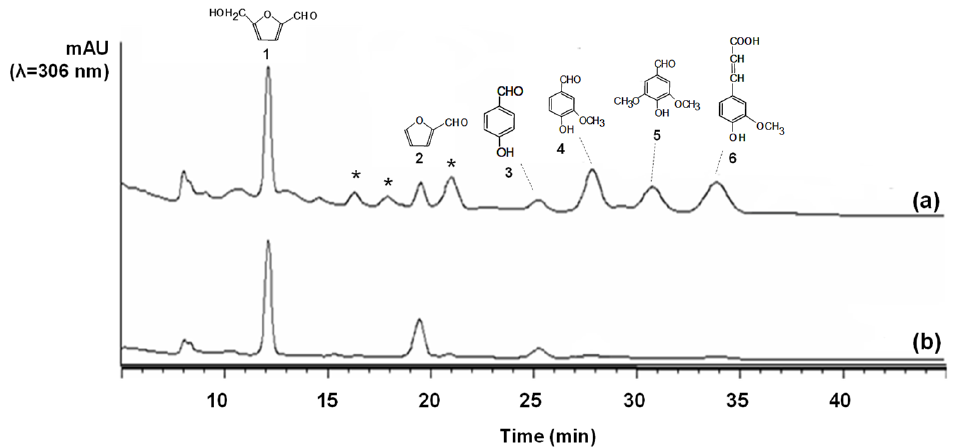
Figure 1. Comparison of high-performance liquid chromatography profiles of inhibitory com- pounds of liquid fraction enzymatic hydrolysates ( a, control; b , laccase). Identified peaks: 1, 5-HMF; 2, Furfural; 3, 4-hydroxybenzaldehyde; 4, vanillin; 5, syringaldehyde; 6, p -coumaric acid. * Non identified phenols.